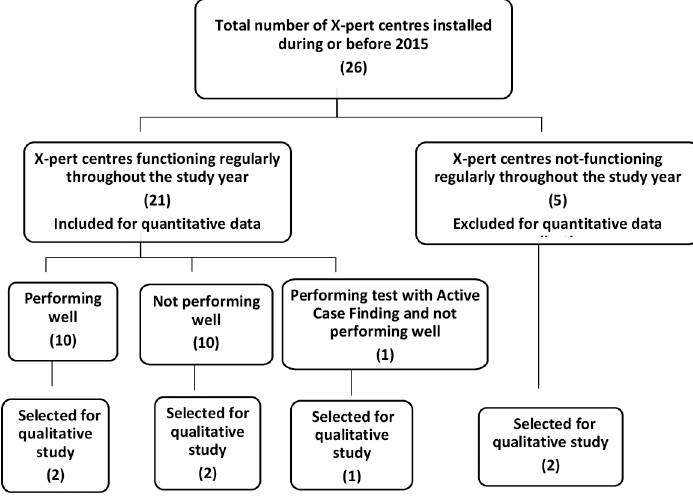
Fig 2. Flowchart for selection of centres for quantitative and qualitative data